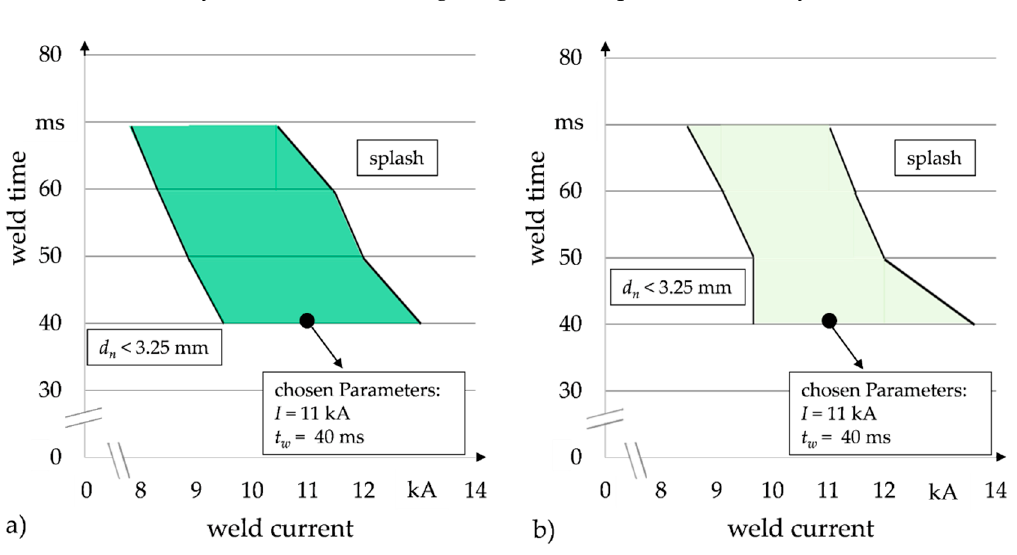
Figure 9. Simulative generated weldability lobes for weld insert type A ( a ) and type B ( b ).